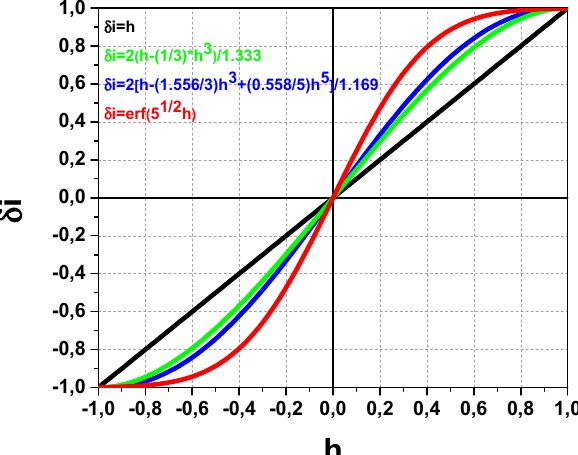
Figure 8. δ i X - h transfer characteristics for uniform (U), parabolic (P) and bell-like (B) profiles.